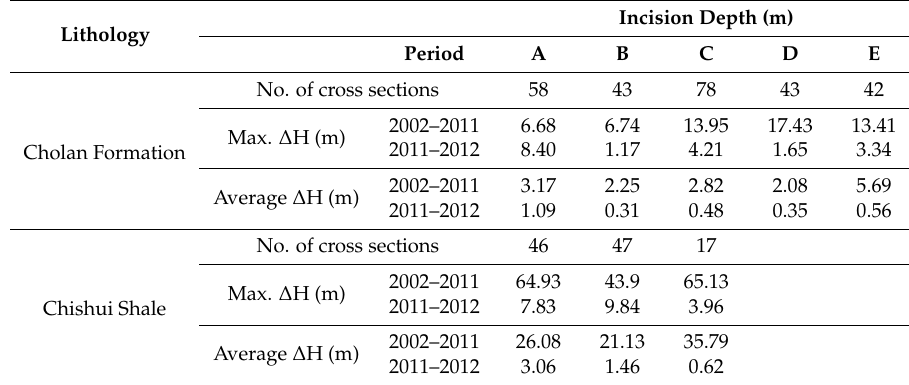
Table 2. The results of gully incision depth calculation by selecting 20 m gully cross sections intervals. Incision Depth (m) Lithology Period A B C D E No. of cross sections 58 Cholan Formation